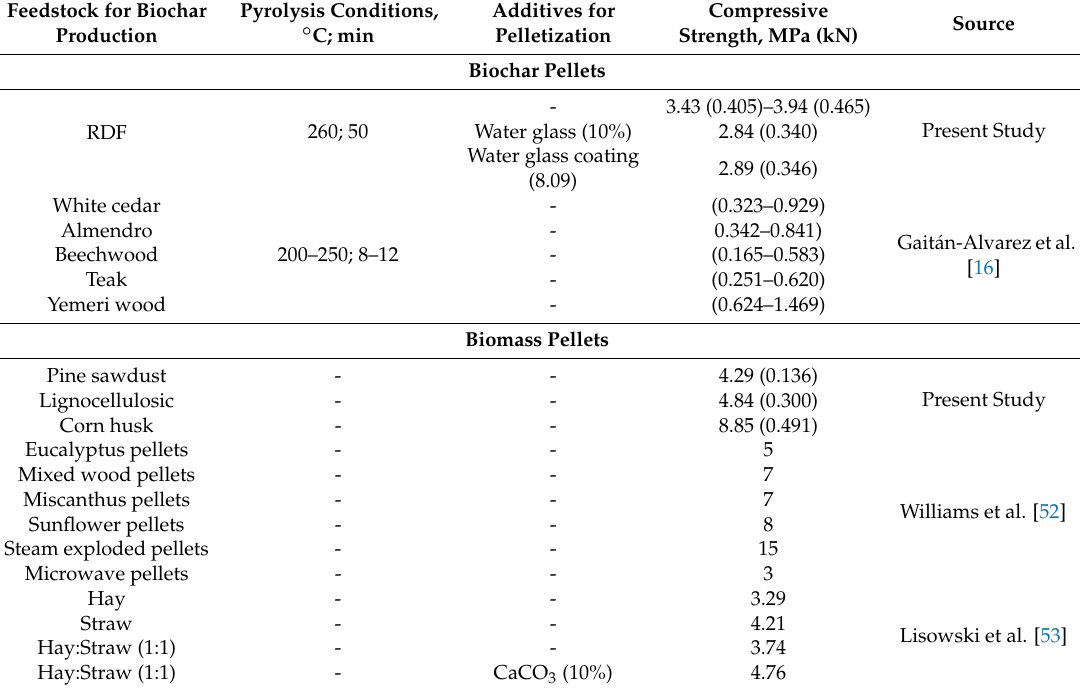
Table 6. Comparison of compressive strength of carbonized refuse-derived fuel (CRDF) pellets with other biomass biochar pellets, and biomass